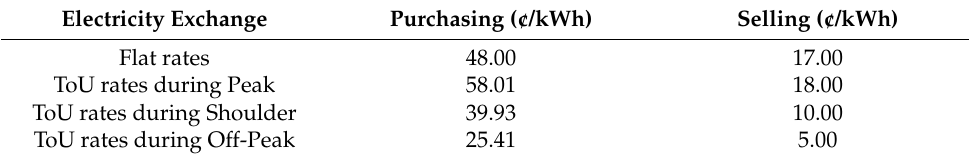
Table 3. Economic data of the proposed EMS.